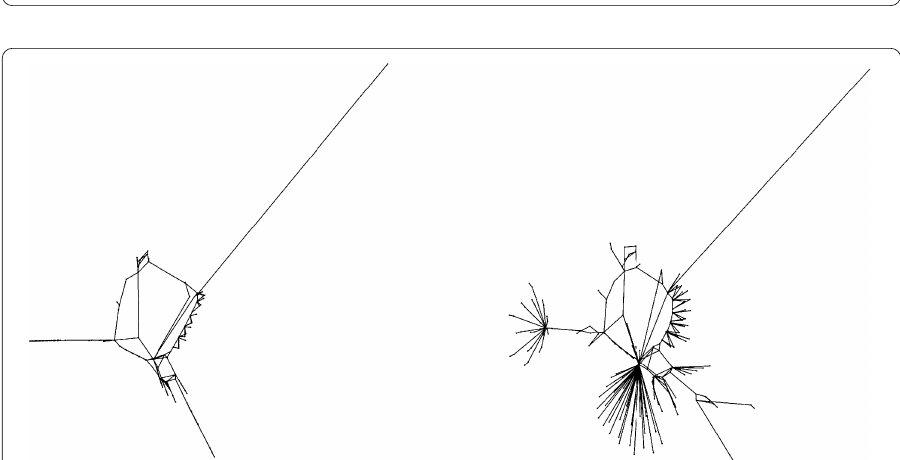
Figure 17 Initial layout and stress majorization with a predetermined distance d new